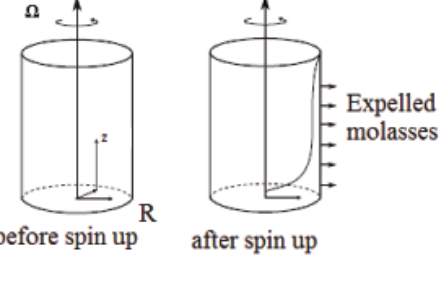
Figure 1. Cylindrical polar coordinate system ( r,θ,z ) for a thin film of molasses draining from sugar crystals. The coordinate system moves with the centrifuge rotating with angular velocity Ω